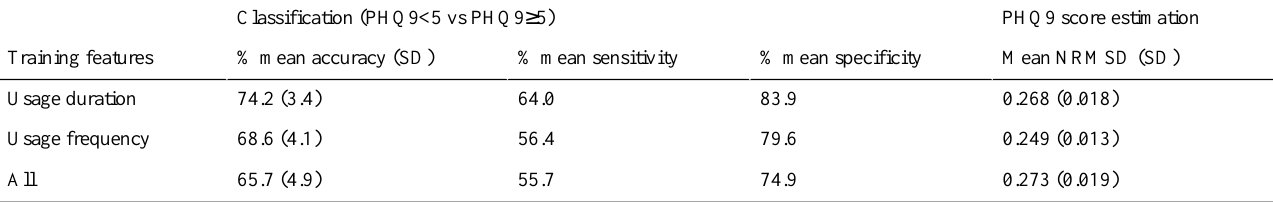
Table 2. Classification of participants with and without depressive symptoms and estimating their PHQ-9 scores using phone usage features individually and